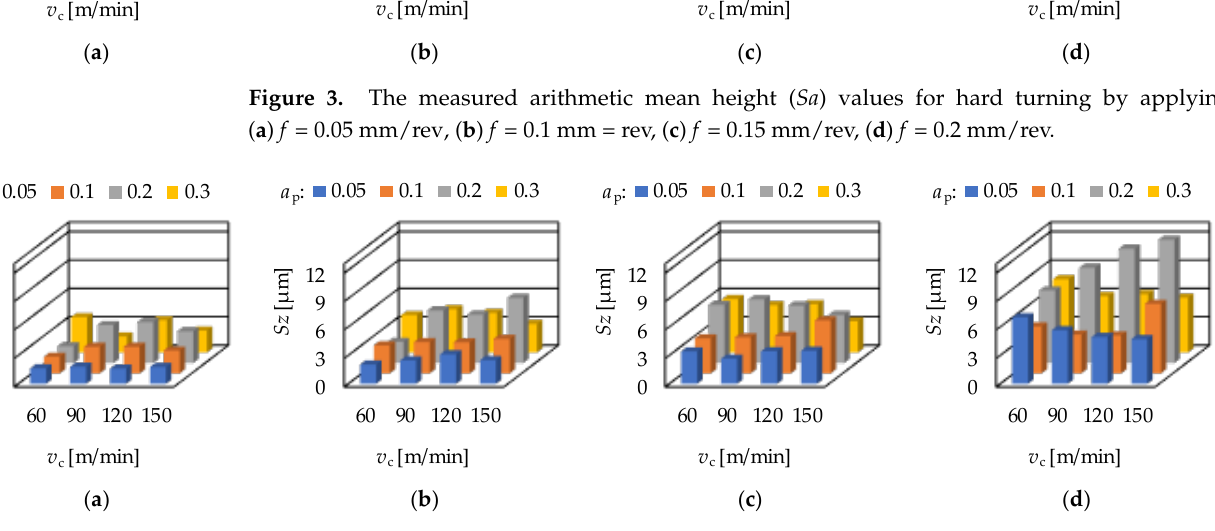
Figure 4. The measured maximum height ( Sz ) values for hard turning by applying ( a ) f = 0.05 mm/rev, ( b ) f = 0.1 mm = rev, ( c ) f = 0.15 mm/rev, ( d ) f = 0.2